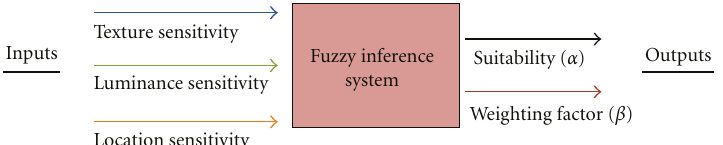
Figure 1: Inputs and outputs of Dynamic Fuzzy Inference System (DFIS).